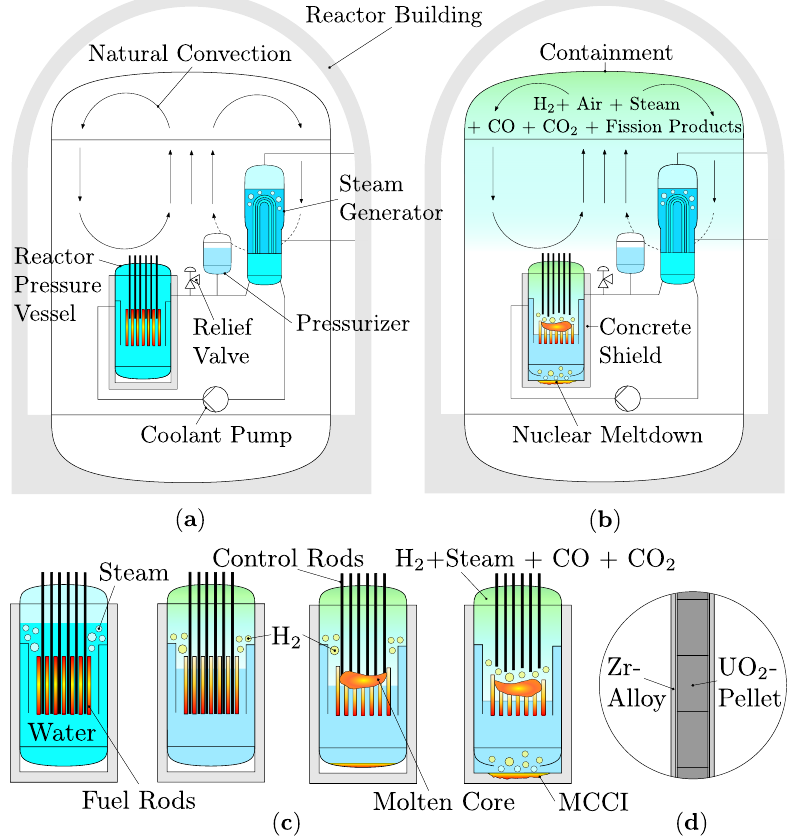
Figure 1. Schematic structure of the primary coolant system in a nuclear power plant and illustration of the processes after a severe nuclear reactor accident: ( a ) nuclear reactor with reactor facilities, ( b ) nuclear reactor after a severe nuclear reactor accident, ( c ) consecutive mechanisms occurring during a nuclear meltdown from left to right, and ( d ) structure of a fuel